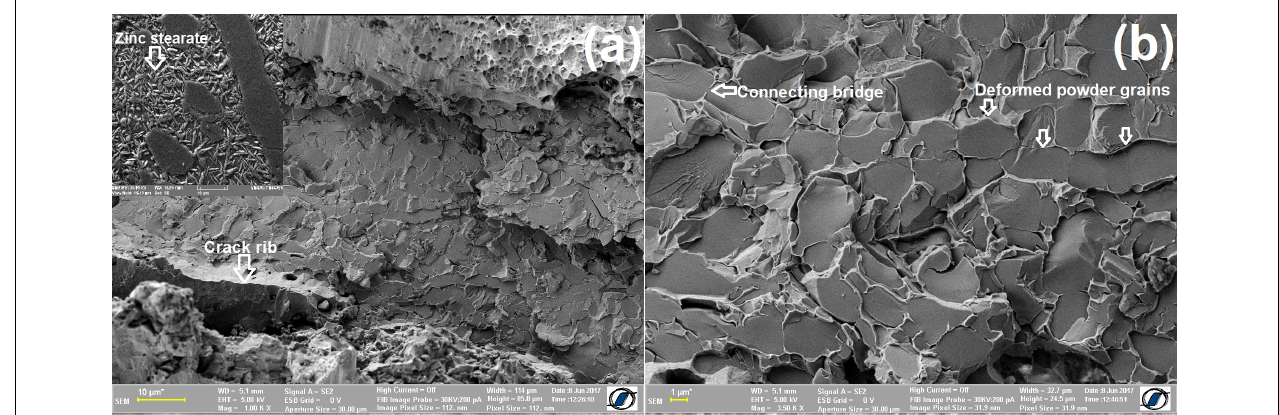
FIGURE 4 | SEM micrographs illustrating sintering effects on 0_MA_700 specimen: (a) brittle general fractographic aspect with detail of an area with Zn stearate segregation; (b) magnified view of an area with connection bridges between deformed powder grains (reproduced after Mocanu et al., 2018, with permission granted by Springer Nature).